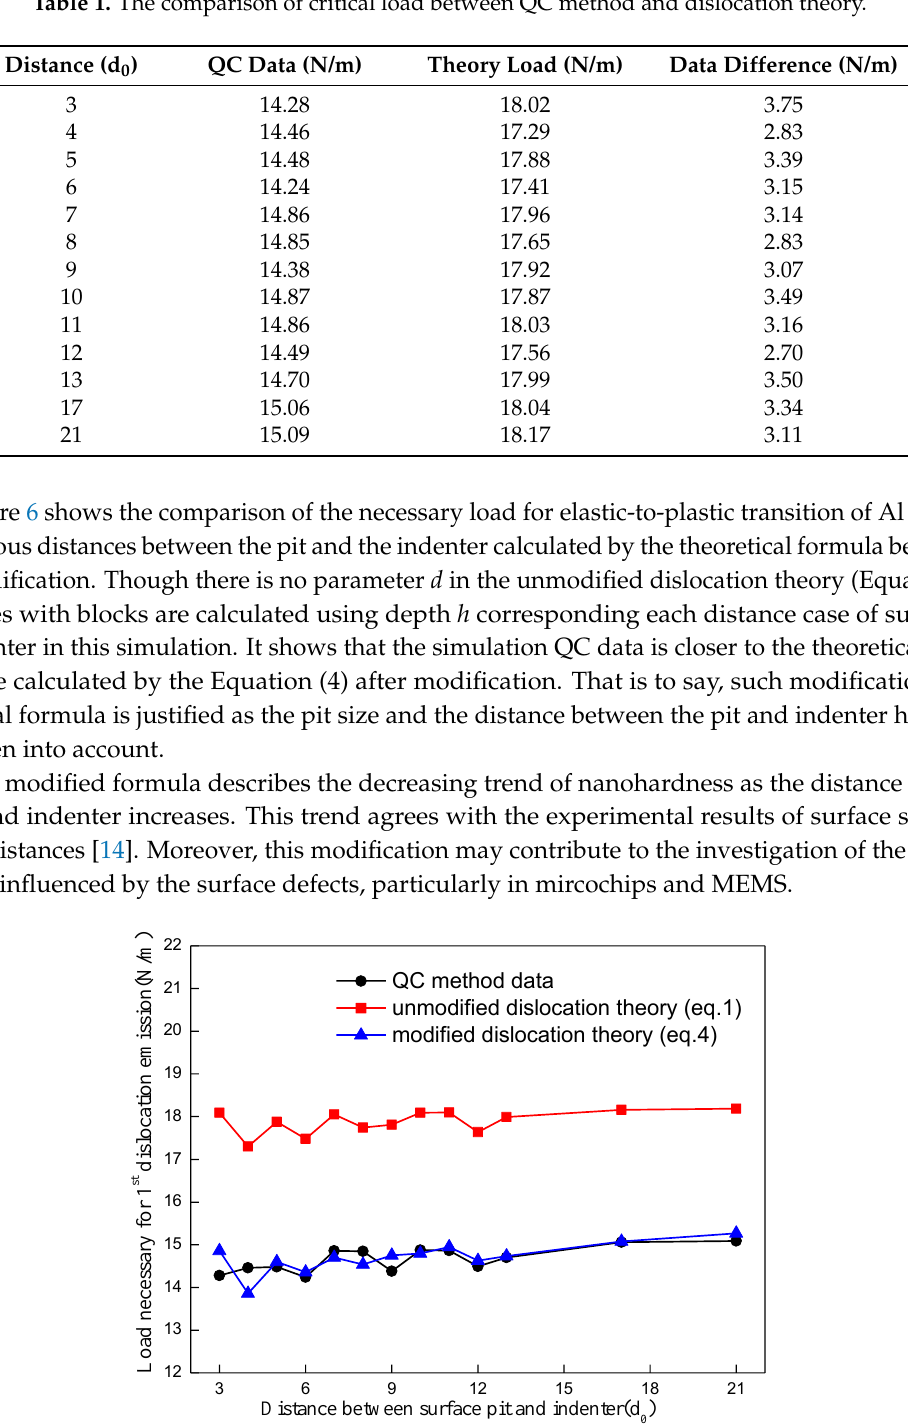
Table 1. The comparison of critical load between QC method and dislocation theory.